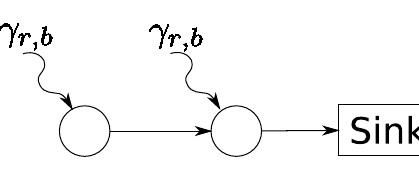
Figure 15. Two-node example